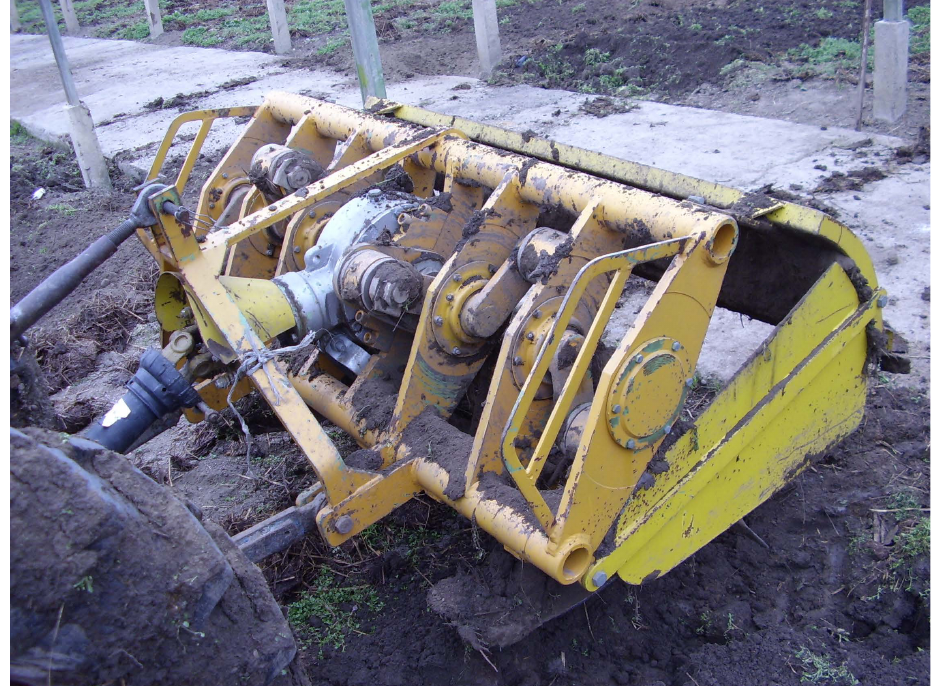
Figure 1. MSS-140-type spading